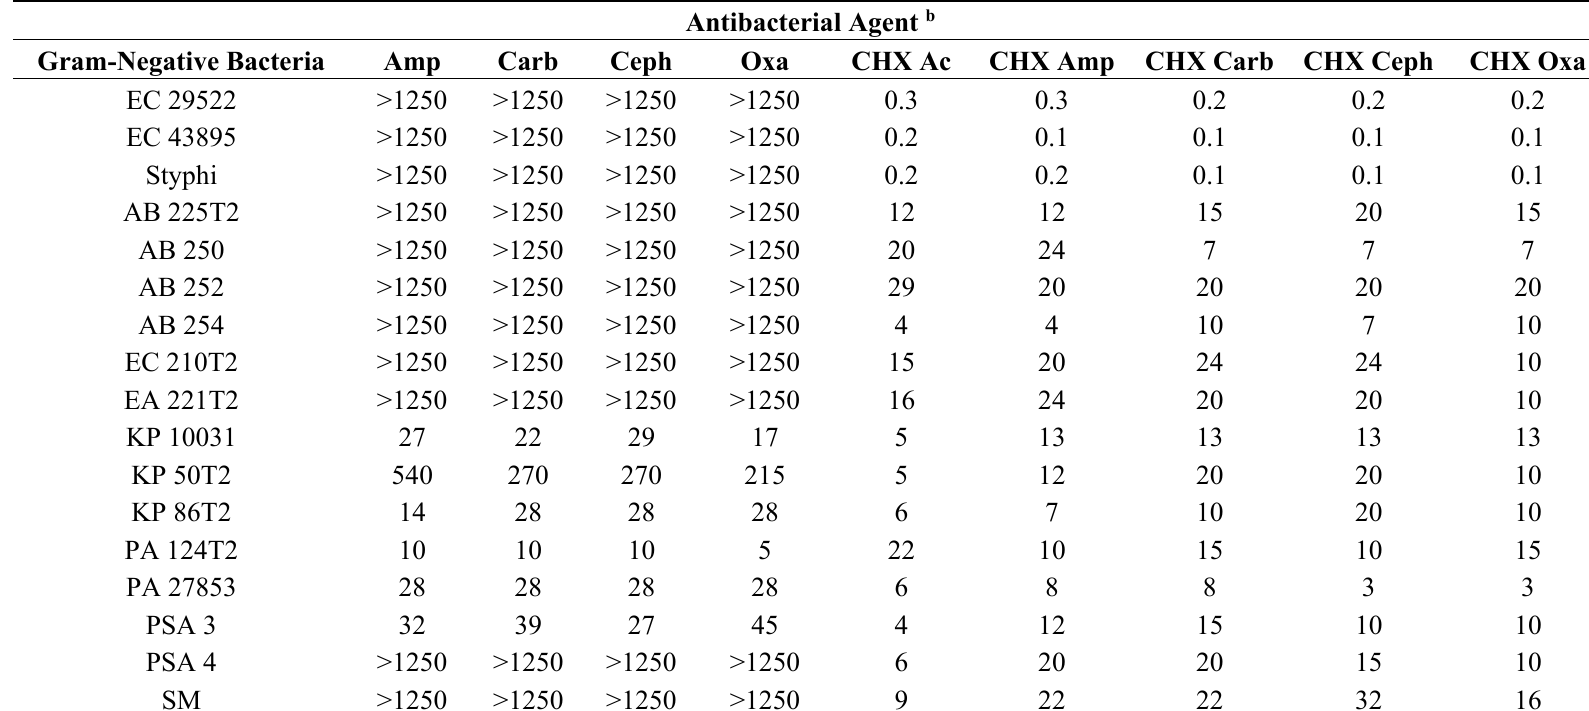
Table 4. MICs (μM) of β-lactam antibiotics, chlorhexidine diacetate and four GUMBOS against 17 clinical isolates of Gram-negative bacteria of varying antibiotic resistance a